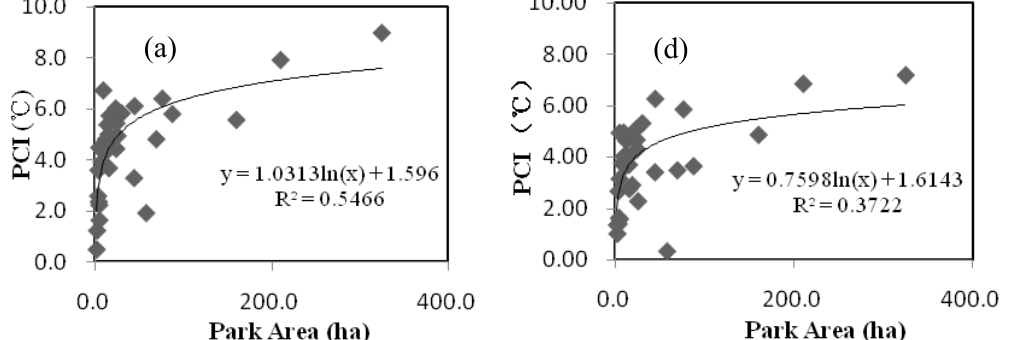
Figure 4. Regression analysis of PCI intensity and urban park size and shape in summer ( a–c ) and in autumn ( d–f ) (n = 33, P <